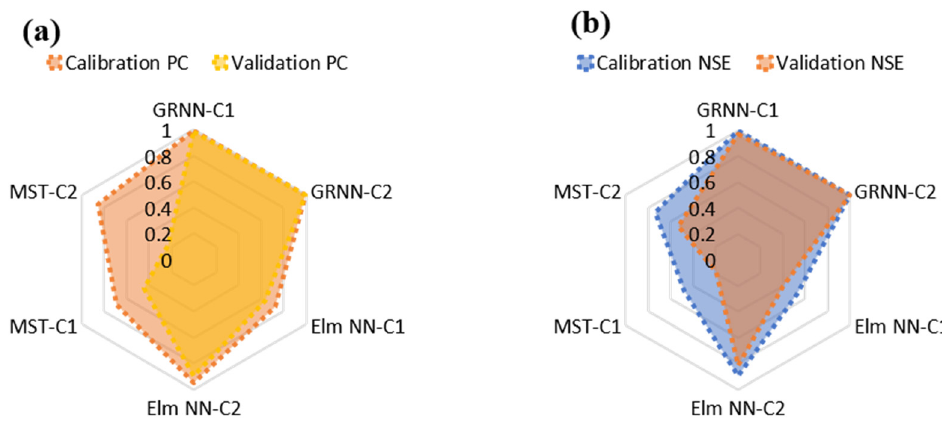
Figure 8. Comparative ( a ) PC and ( b ) NSE performance of the GRNN, Elm NN, and MST techniques for the Cr concentration (mg/kg) estimation in both calibration and validation.